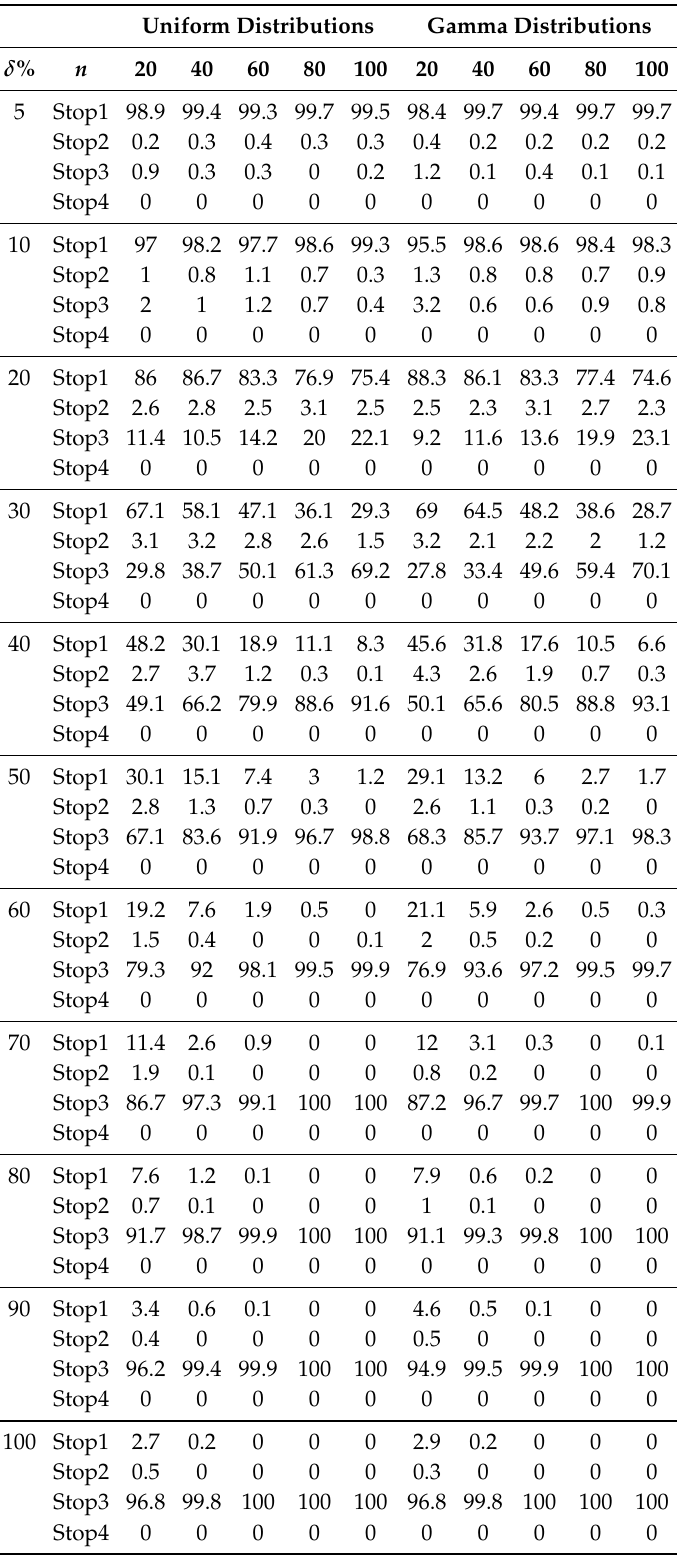
Table A7. Computational results for randomly generated instances with the ratio 5%:15%:5%:75% of the numbers of jobs in the subsets J 1 , J 2 , J 1,2 and J 2,1 of the job set J